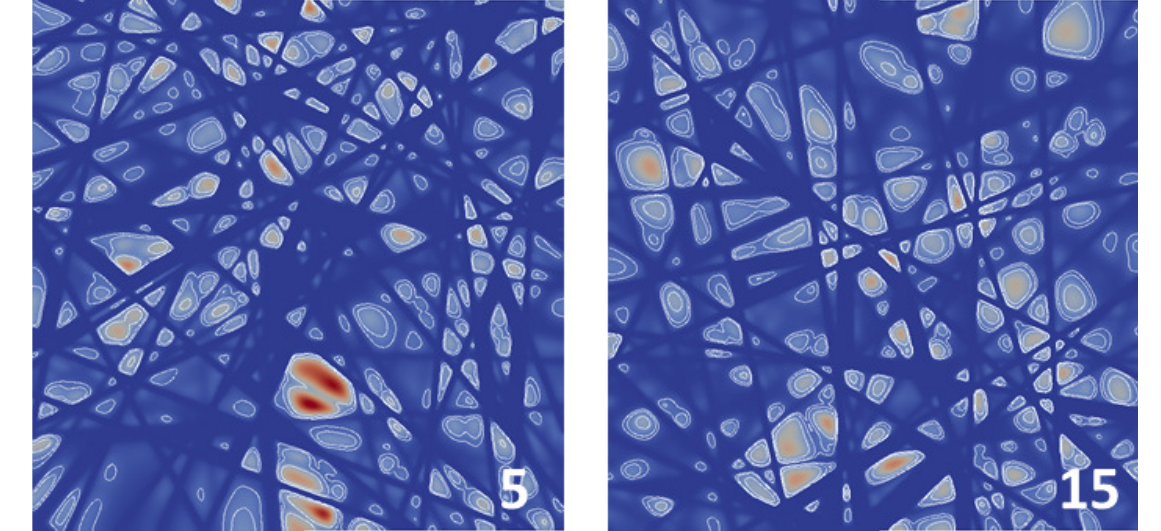
Figure 5. Velocity at the GDL/channel interface for realization Nos. 5 and 15. Mass-related quantiles for q = 70%, 50%, and 20%.